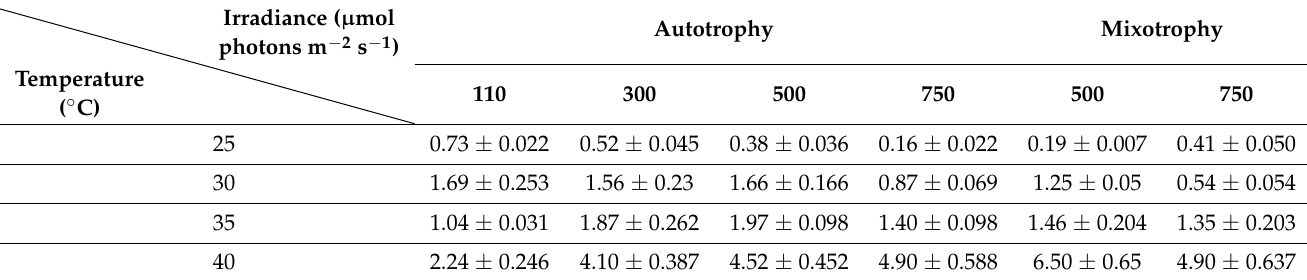
Table 1. Effect of different temperatures and irradiances under autotrophic and mixotrophic regimes on the growth